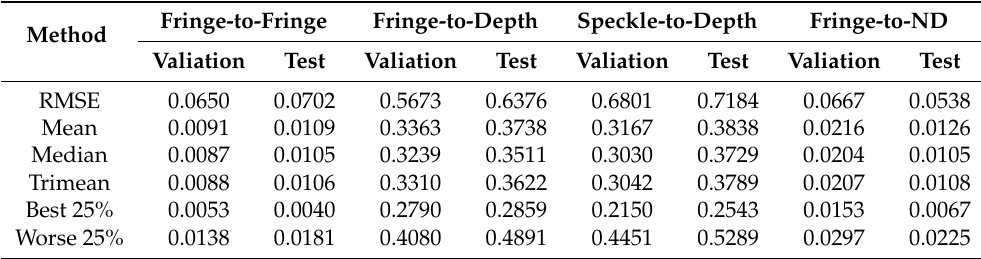
Table 2. Quantitative performance of fringe-to-fringe, fringe-to-depth, and speckle-to-depth, and fringe-to-ND networks (unit: